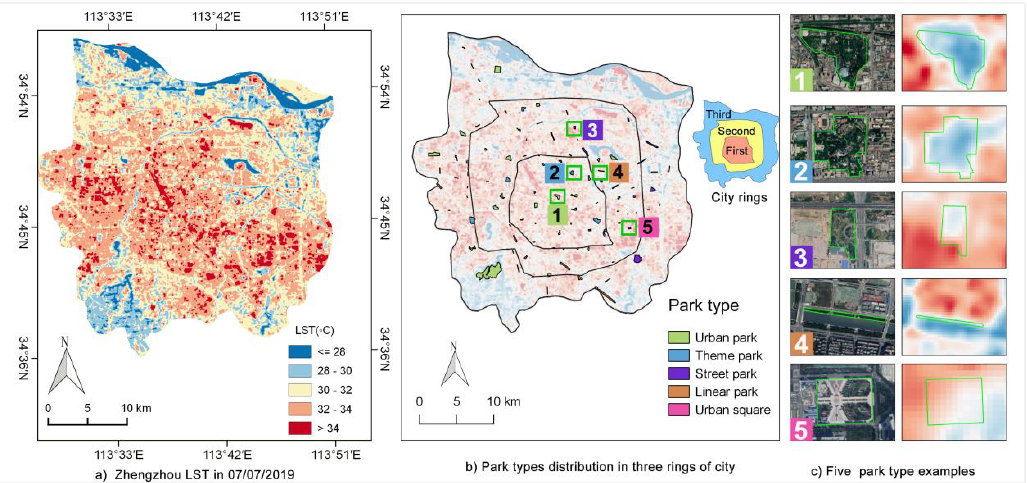
Figure 2. ( a ) LST map of Zhengzhou city in 07 July 2019; ( b ) Distribution of 123 parks samples; ( c ) Five park type examples: 1-urban park; 2-theme park; 3-street park; 4-linear park; 5-urban square. Table 5. Statistics of LST and average PCI in di ff erent park